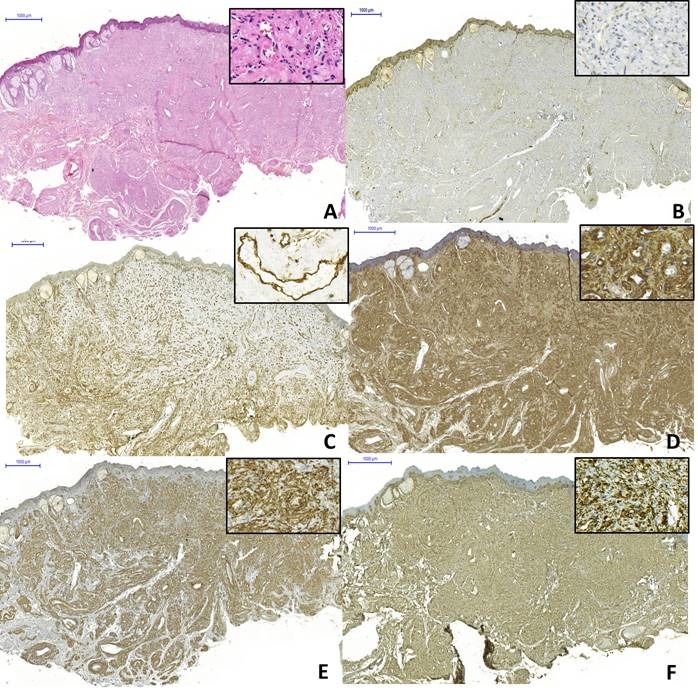
Morphological and immunohistochemical features of angioleiomyoma. (A) proliferation of cells with varied morphology (ovoid, fusiform, and ondulated) arranged in disorganized bundles and surrounding multiple blood vessels (Hematoxylin & eosin, 100 µm); (B) Absence of immunostaining of tumor cells for S100 protein; (C) Positive staining for CD34 restricted to vascular walls; (D-F) Strong and diffuse immunostaining for proteins α-SMA, H-caldesmon, and desmin, respectively (100 µm).